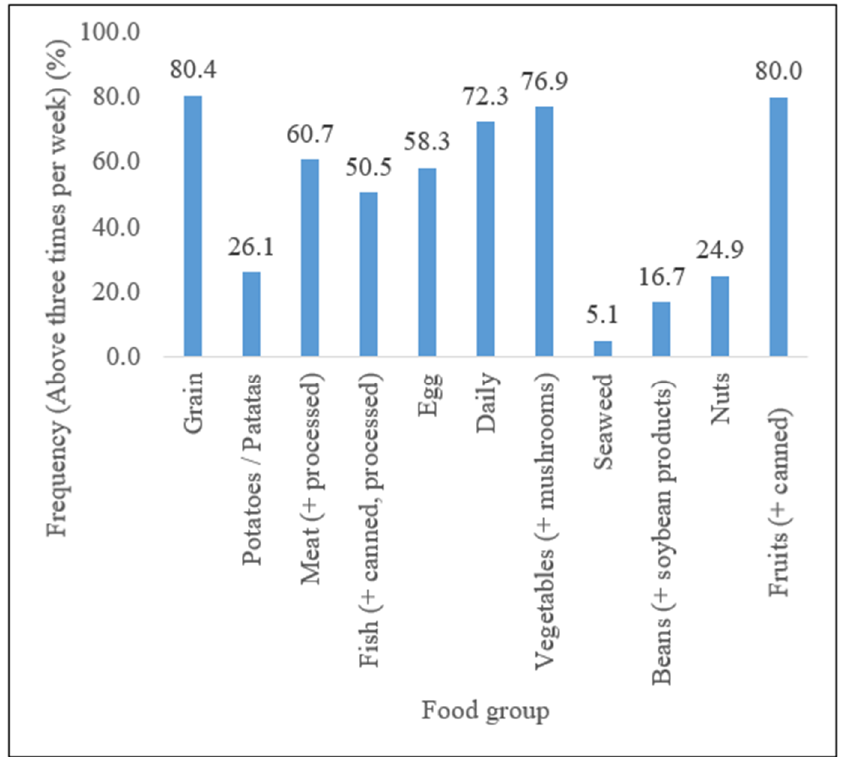
Figure 1. Food groups consumed by the participants over a week in the previous six months. Approximately half (50.5%) of the respondents reported consuming fish, includ- ing canned and processed fish. Less than a third of the respondents consumed pota- toes/ patatas , nuts, beans (plus soybean products), and seaweed (26.1%, 24.9%, 16.7%, and 5.1%,